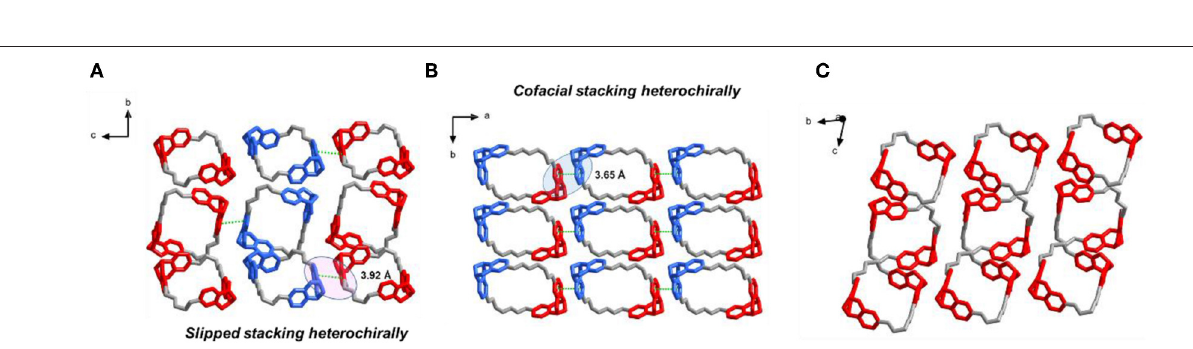
FIGURE 2 | Crystal structures of enantiopure R 4 N - T1 (A) , enantiopure S 4 N - T1 (B) , and R 2 N S 2 N -T1 (C) assigned to corresponding chemical structures of stereoisomers. TB units with S N S N is depicted in red, while TB units with R N R N is shown in blue.